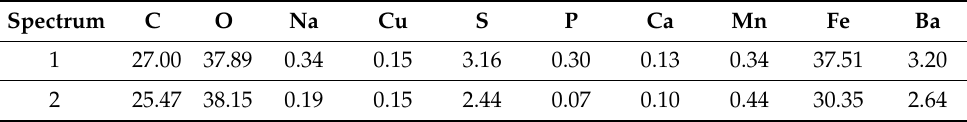
Table 4. EDS results of corrosion scale formed on L245N standard steel after 2 days of testing, (at. %). The spectrum labels correspond to Figure